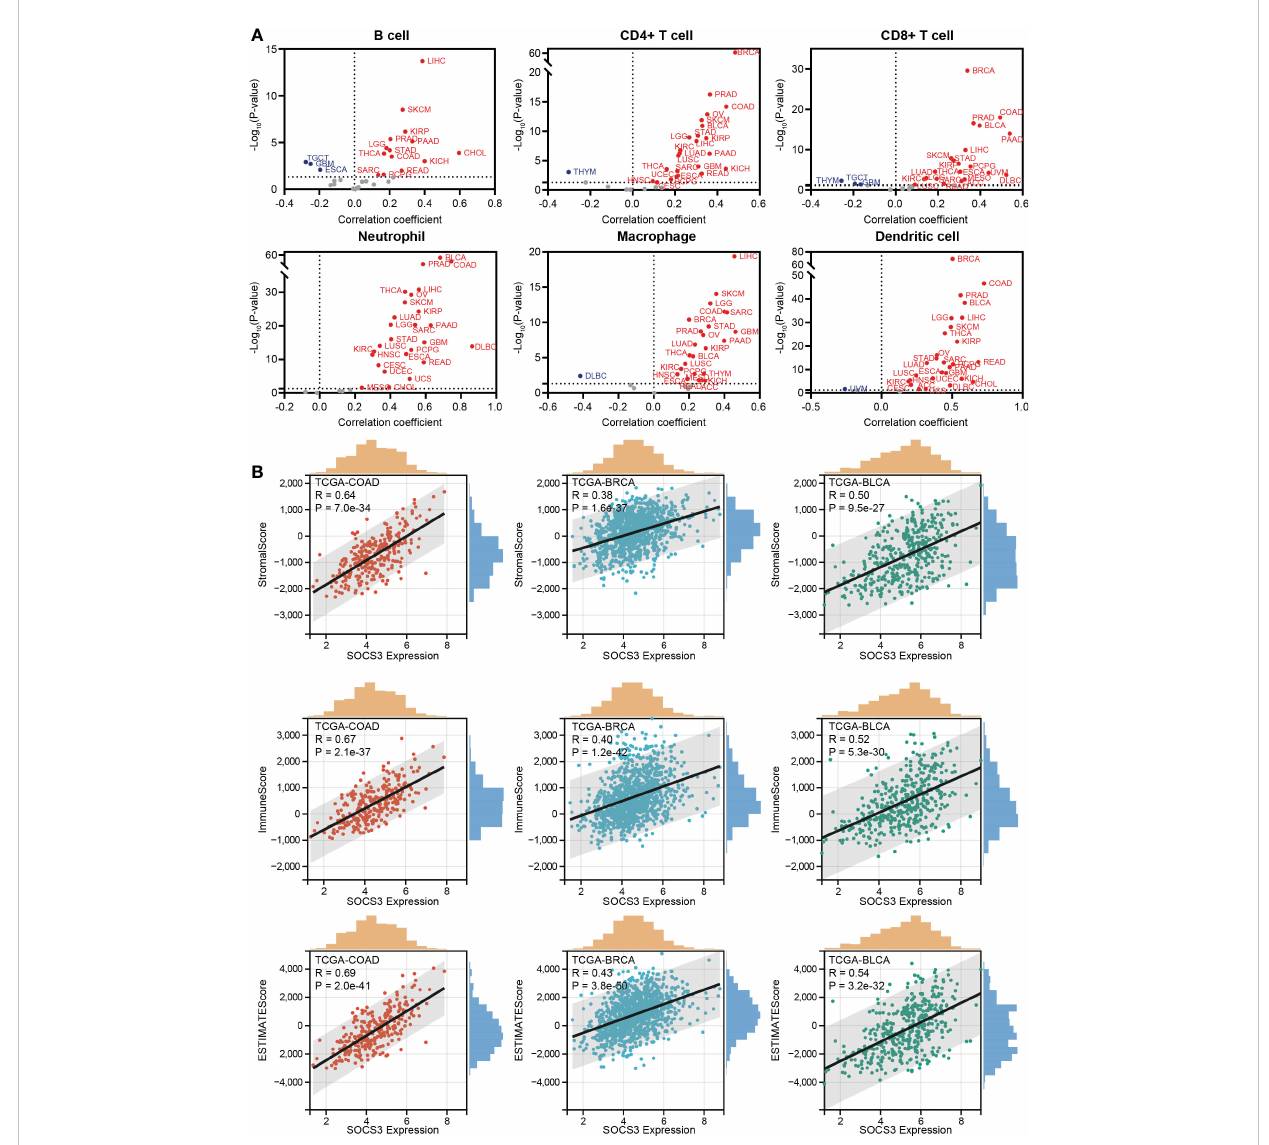
FIGURE 2 Relationship between SOCS3 expression and immune response. (A) The correlation between SOCS3 expression and main immune cell in fi ltration in different tumors, including B cell, CD4+ T cell, CD8+ T cell, neutrophil, macrophage, and dendritic. Red point: a positive correlation. Blue point: a negative correlation. (B) The 3 most signi fi cant related tumors in StromalScore, ImmuneScore, and ESTIMATE